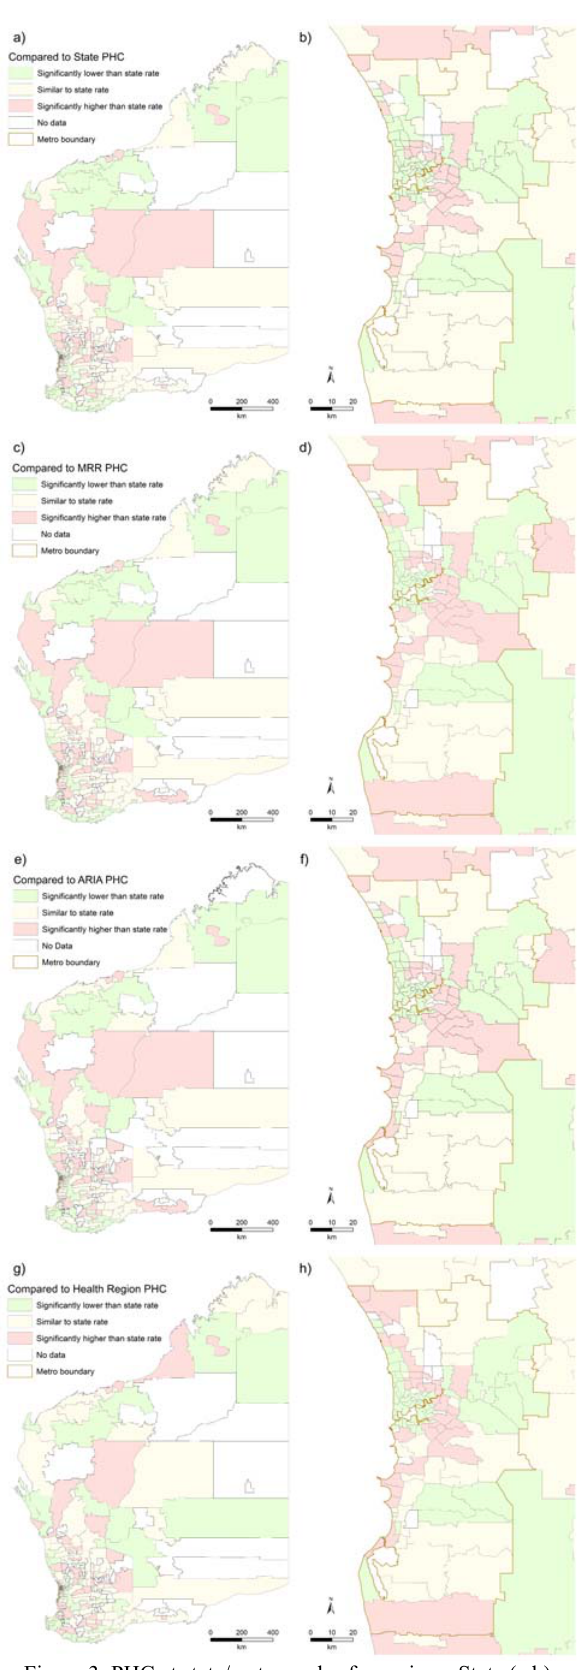
Figure 3. PHC at state/metro scales for regions: State (a,b), MRR (c,d), ARIA-based (e,f) and Health Region (g,h)